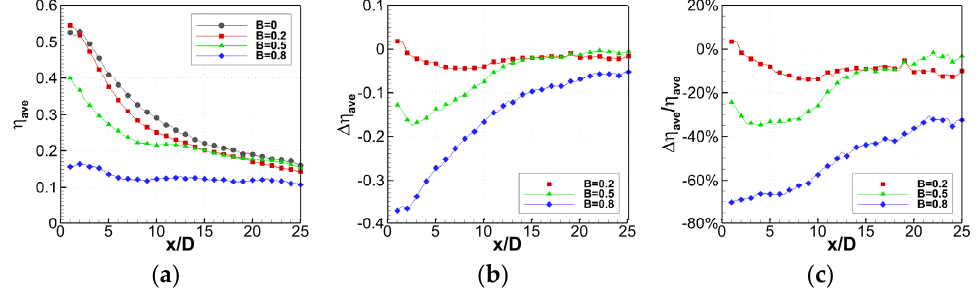
Figure 12. Effect of blockage ratio on spanwise averaged film effectiveness at M = 1.05. ( a ) η ave ; ( b ) ∆ η ave ; ( c ) ∆ η ave / η ave .